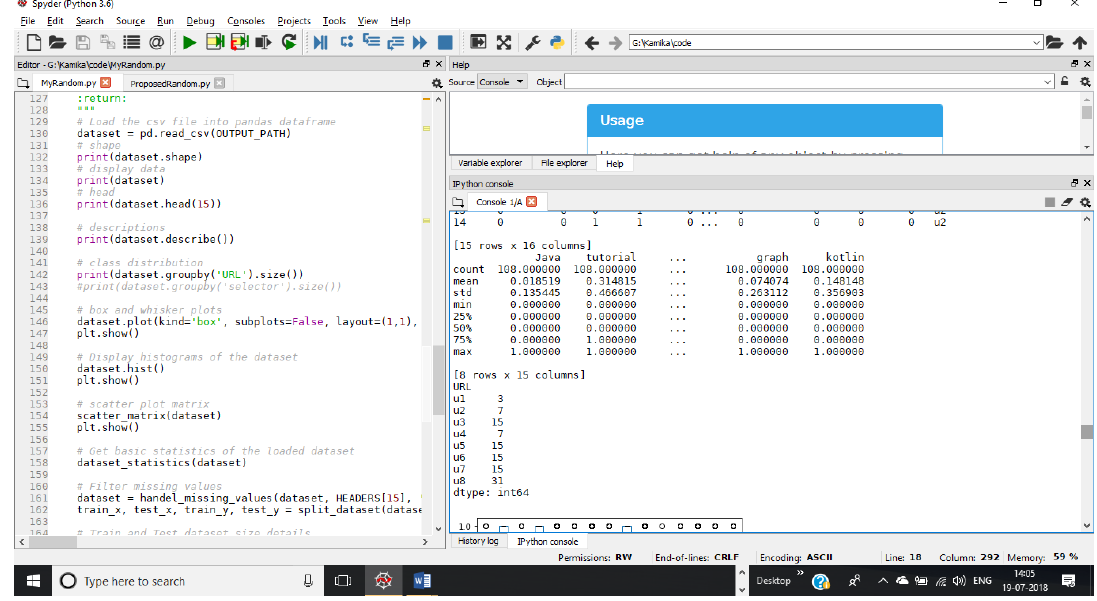
Figure 5. URL classification considered for